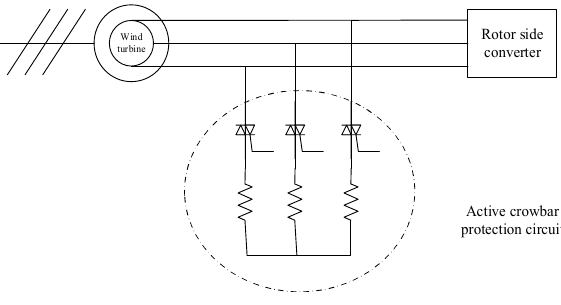
Figure 4. Schematic of active crowbar protection circuit.